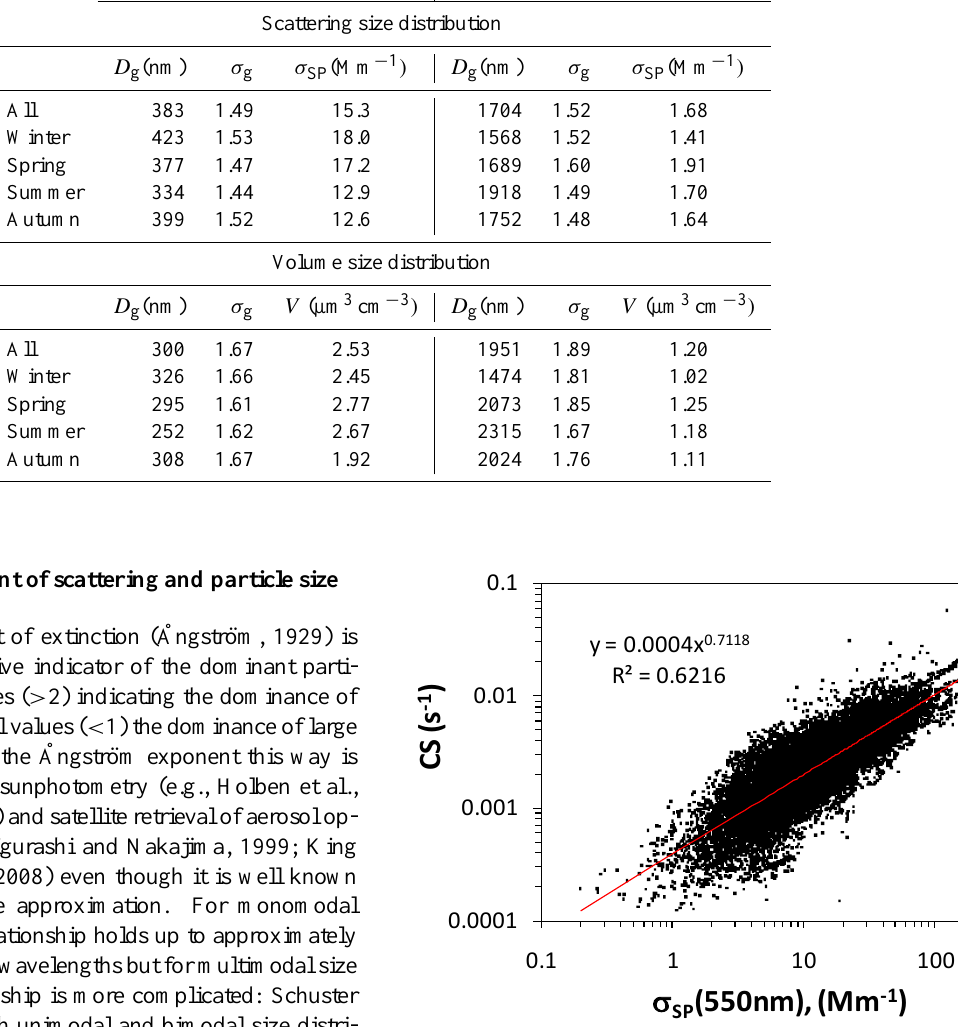
Fig. 12. Relationship of condensation sink (CS) and σ SP at λ =